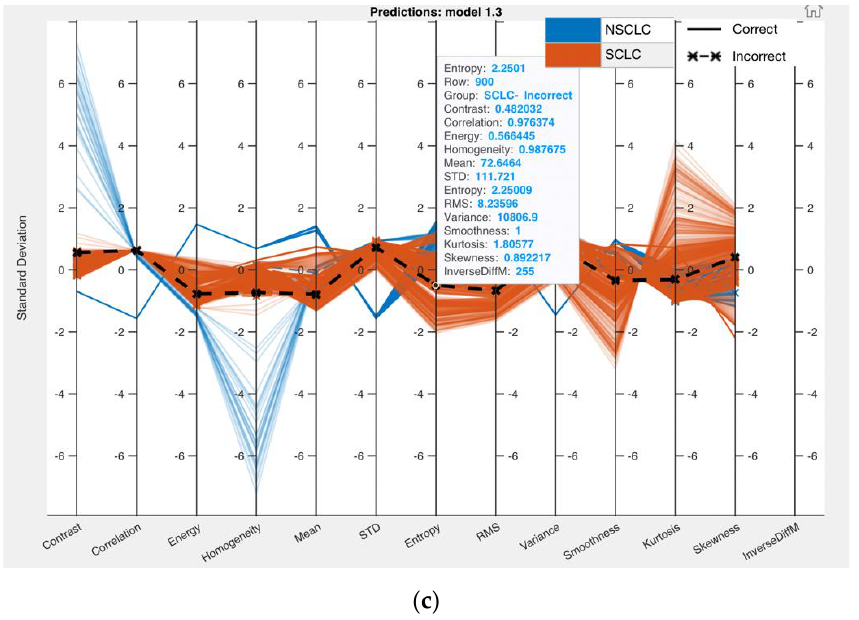
Figure 9. Parallel prediction plots ( a ) using gamma correction at gamma = 0.04 on predictions, ( b ) gamma correction with gamma = 0.5 on predictions, ( c ) gamma correction with gamma = 0.04 data using 1 std . Table 1 reflects the results based on data augmentation methods to avoid overfitting. Table 1. Lung cancer detection performance based on data augmentation with gamma correction (gamma = 0.5), and applying the ML methods.